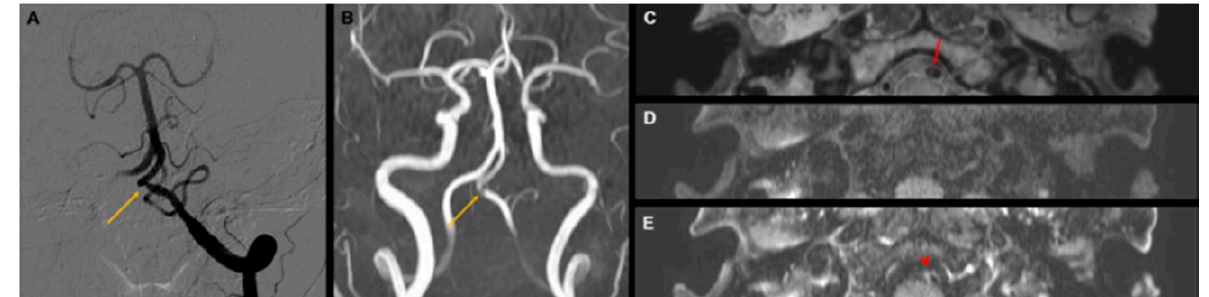
Figure 5. A representative case of vertebral artery dissection. A 57-year-old woman patient presented with severe headache. Cerebral angiography ( A ) and time-of-flight MRA ( B ) showing the only focal stenosis at the left V4 segment of the vertebral artery (yellow arrow). ( C ) The intimal flap sign (red arrow) presents as iso-signal intensity on proton-density high-resolution vessel wall imaging (HR-VWI). The double-lumen sign is also observed. ( D , E ) Periarterial enhancement (red arrowhead) on contrast-enhanced T1-weighted